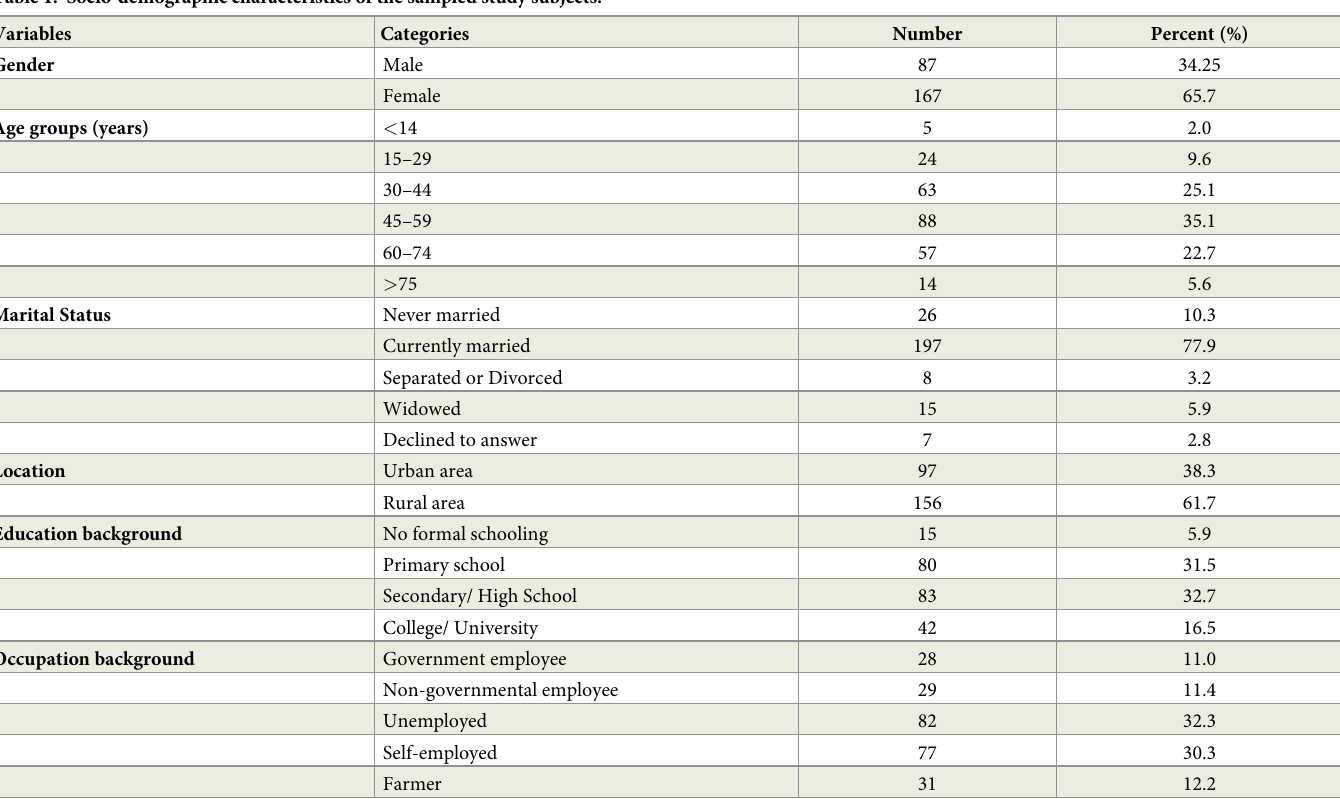
Table 1. Socio-demographic characteristics of the sampled study